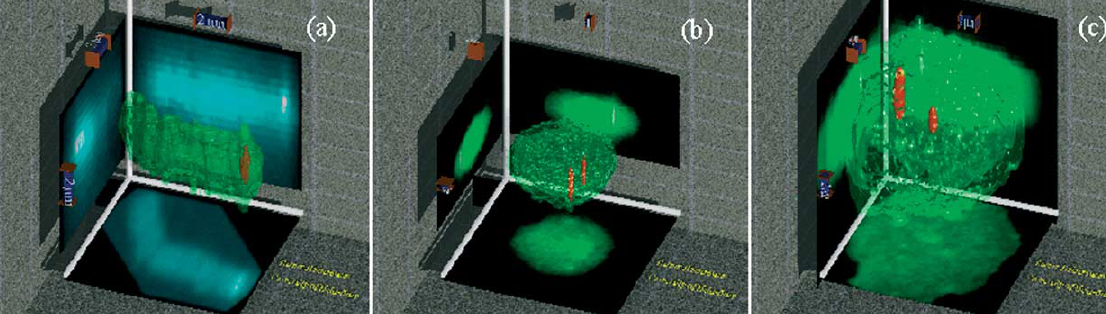
Fig. 2. 3D-image of a metaphase chromosome 9 (a) and cell nuclei obtained from a lymphocyte preparation of peripheral blood (b) and a bone marrow smear (c) after specific labelling of the abl gene (9q34) by COMBO-FISH using a combination of 32 pyrimidine oligo-nucleotides labelled with two dye-molecules Alexa 514 each. The oligo-probes co-localise only at the abl gene shown in red false colour. The FISH procedure was performed without thermal denaturation of the target DNA. For image acquisition a laser scanning microscope was used. The 3D-image was obtained from an image stack of optical sections. The bottom and the back show the maximum projections of the 3D-image in each direction.